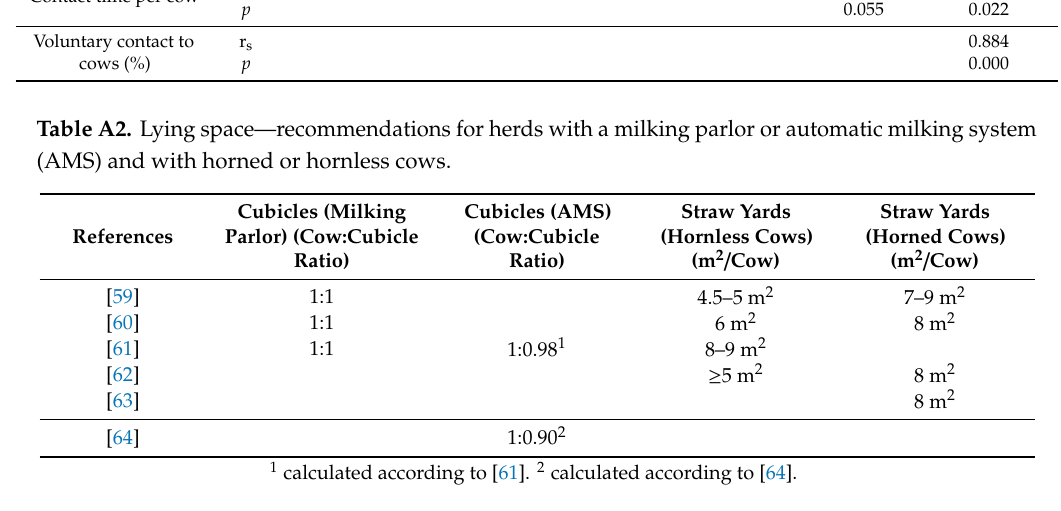
Table A3. Lying space—categories for analyses derived from recommendations.